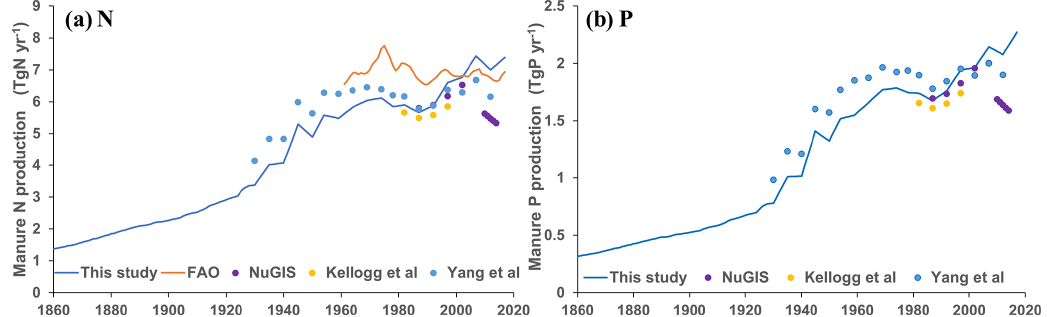
Figure 9. Comparison of manure nutrient production in this study with the four previous datasets.